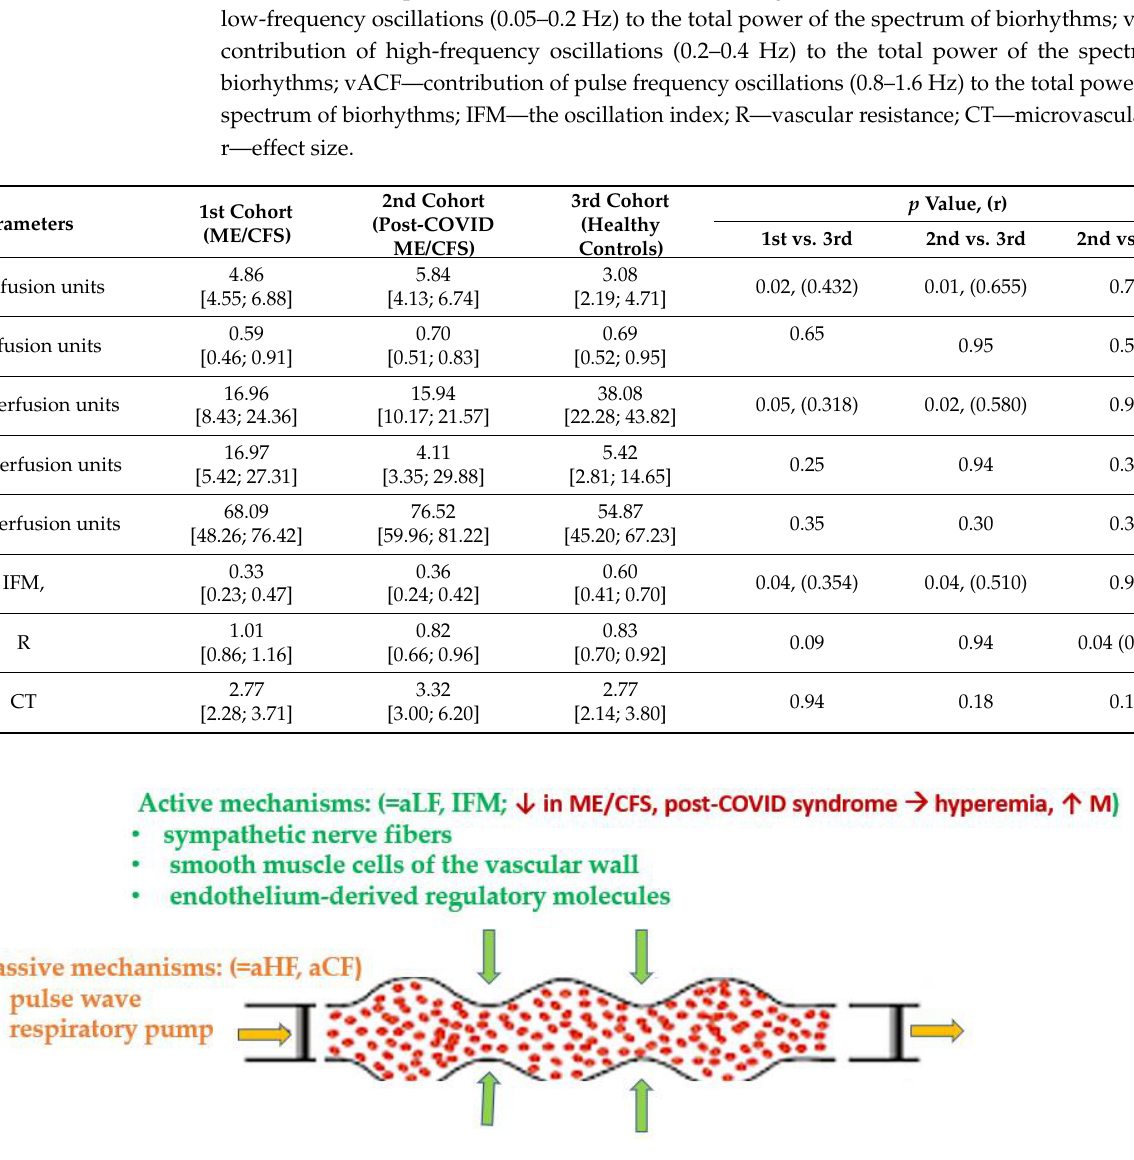
Figure 2. Interpretation of the microcirculation changes in ME/CFS and post-COVID ME/CFS. Active and passive mechanisms regulate microcirculation, as discussed below. The decreased activity of the active mechanisms underlies the hyperemic form of microcirculation disorder observed in ME/CFS and post-COVID-19 ME/CFS. aCF—contribution of pulse oscillation; aHF—contribution of high-frequency oscillation; aLF—contribution of low-frequency oscillation; IFM—oscillation index, M—average value of tissue perfusion with